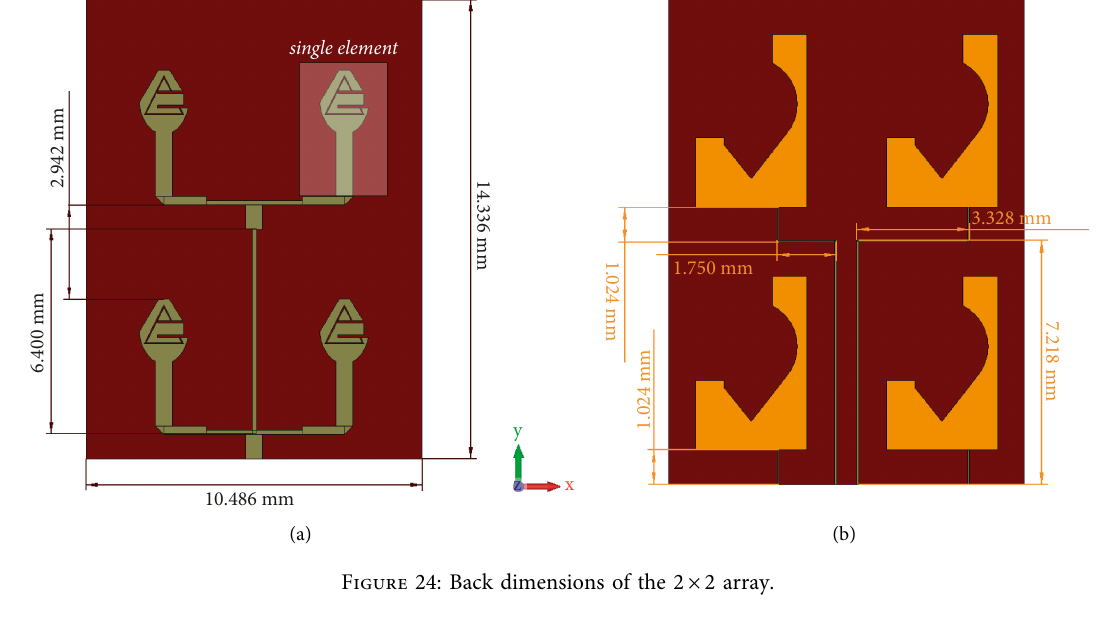
Figure 24: Back dimensions of the 2 × 2 array.